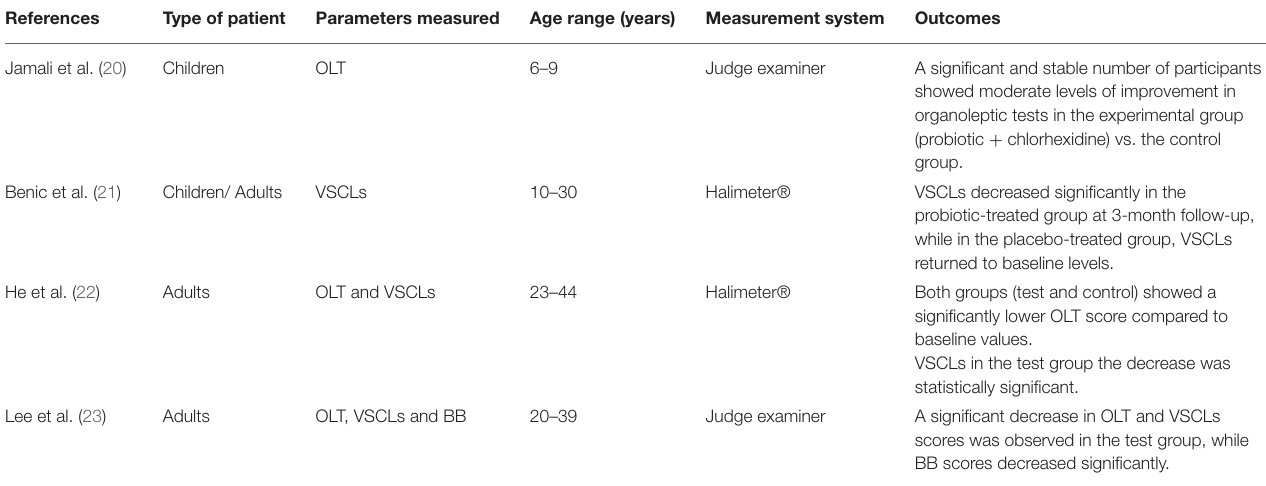
TABLE 2 | Patients and parameters measured in the included